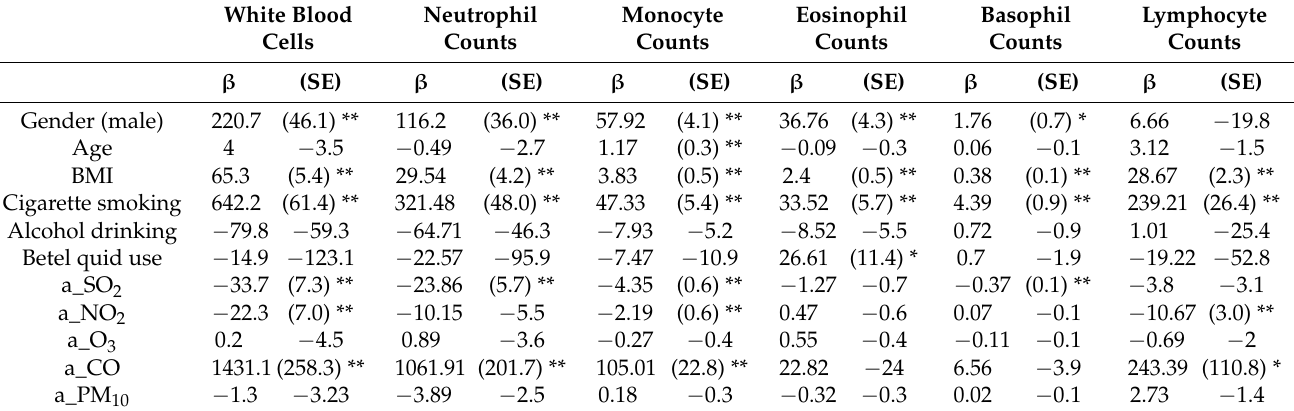
Table 5. Multiple-pollutants model: the associations of combined effects between common air pollutants and white blood cell series.